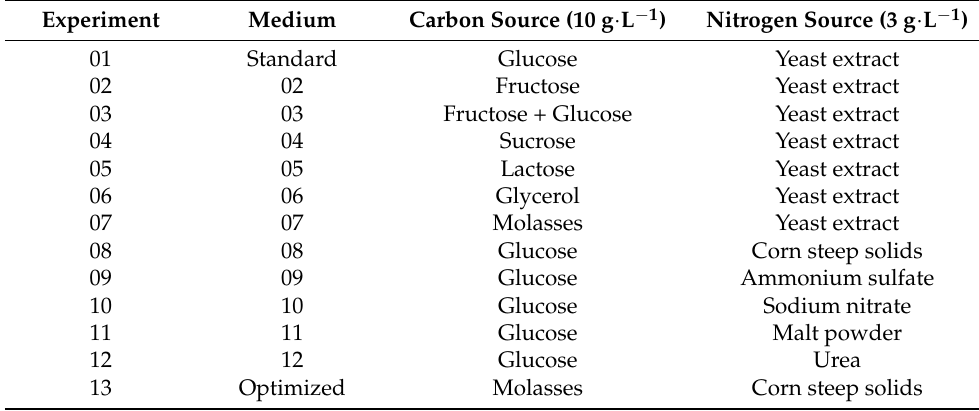
Table 1. Carbon and nitrogen sources in culture medium for standard and alternative culture media used to produce ALDC by B. subtilis ICA 56. The remaining media components were kept constant. Experiments were carried out in a rotary shaker at 37 ◦ C, 150 rpm, for 14